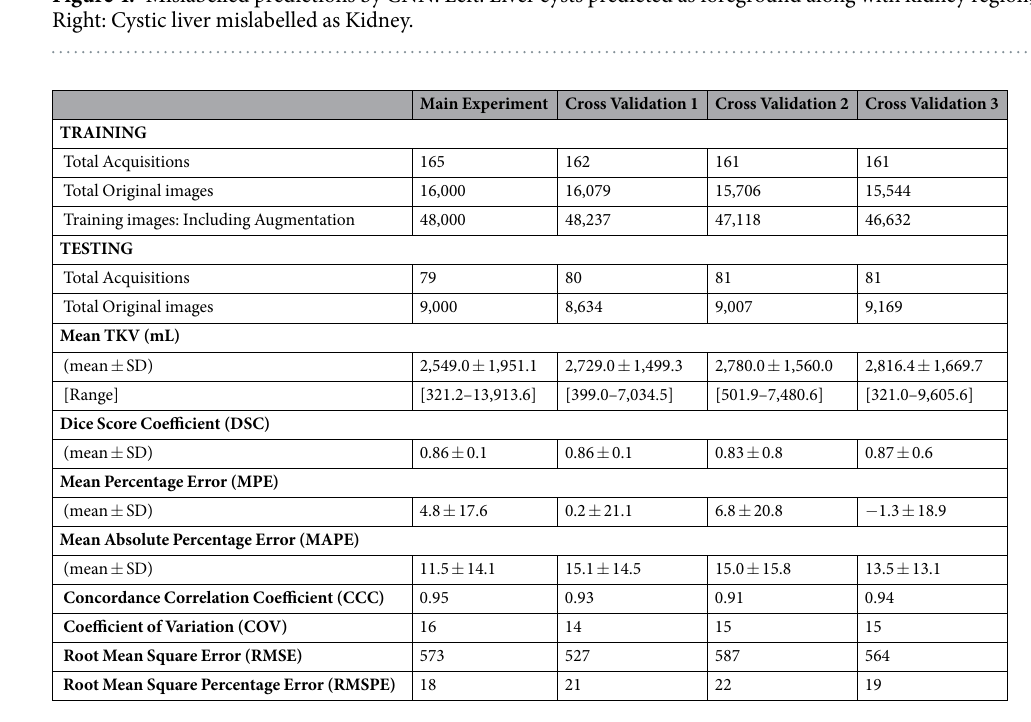
Table 2. Cross Validation Experiments. 3-fold cross-validation to assess the performance of our fully convolutional neural